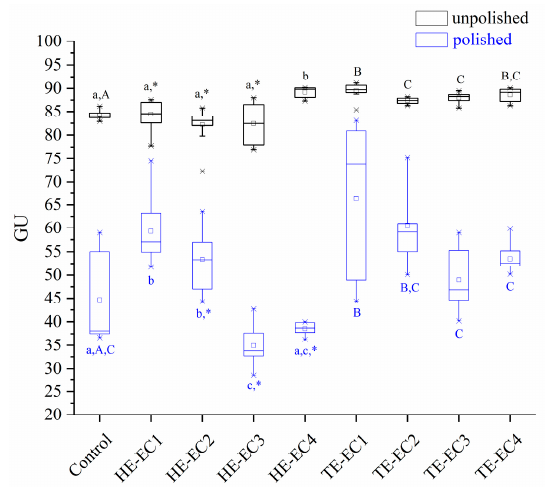
Figure 2. Surface Gloss (GU) mean values of experimental composite resins. The same lower letters indicate that there is no significant difference in surface gloss between experimental composite resins with different weight fractions of HE-Phene in the resin matrix. The same upper letters indicate that there is no significant difference in surface gloss between experimental composite resins with different weight fraction of TE-Phene in resin matrix. The asterisk * indicates the statistical differences between composites with different Phene like monomers at the same mass fraction in resin